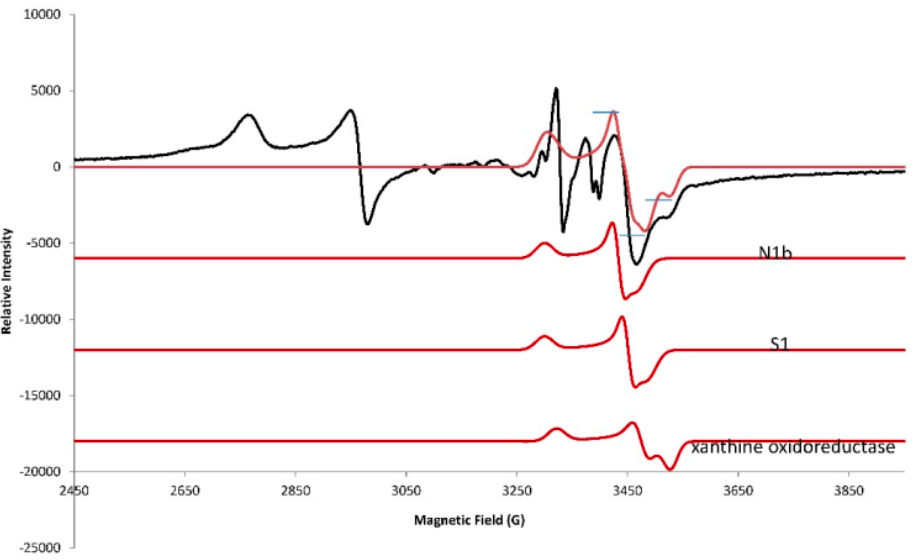
Figure 8. Simulation of 2Fe2S for N1B, S1, oxidoreductase. EPR spectrum for liver tissue sample (black) at 110 K and simulations for 2Fe2S clusters (red). Bottom (xanthine oxidoreductase): g = 2.02, 1.93,